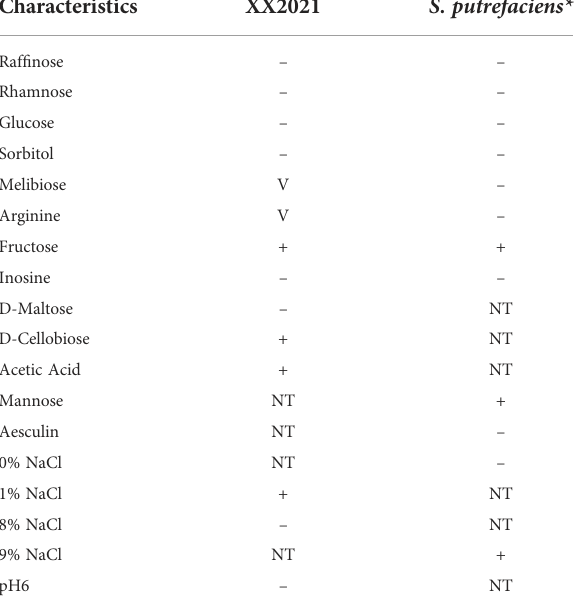
TABLE 2 Physiological and biochemical characteristics of strain XX2021.